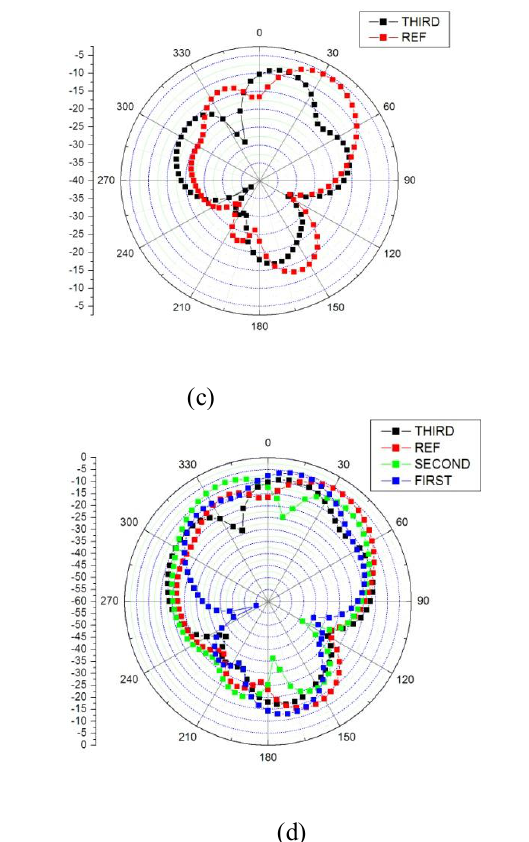
Figure 14: Scanning of the antenna beam with respect to (a) 1 st bit (b) 2 nd bit (c) 3 rd bit (d) composite